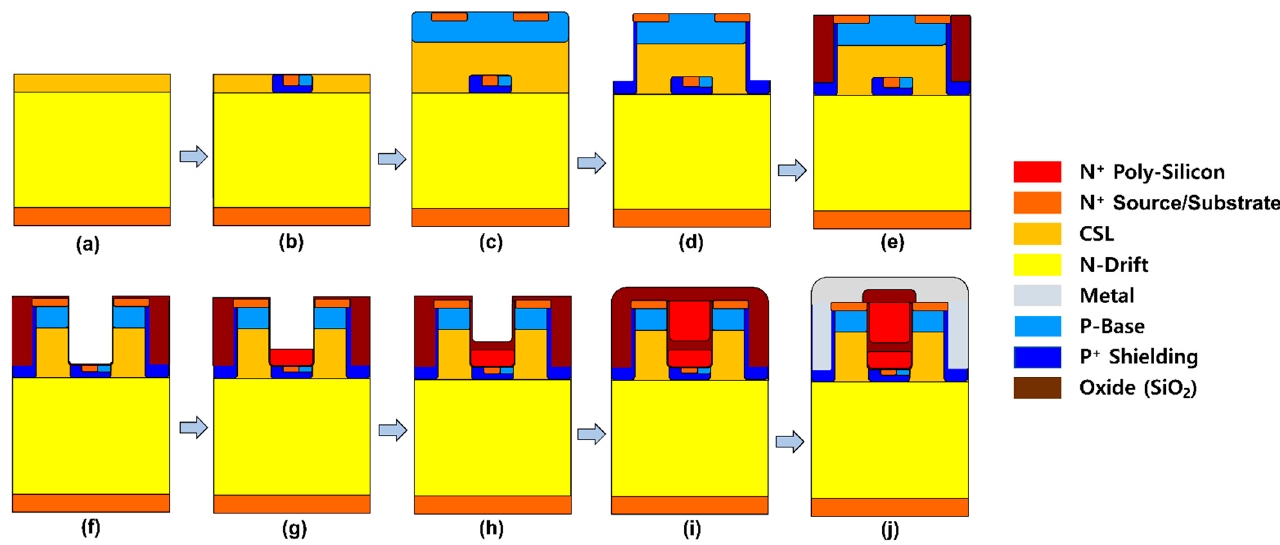
Figure 3. Proposed fabrication procedure of DTMCD-MOSFET. ( a ) N-drift region and CSL region formed by epitaxial growth on N+ substrate. ( b ) BPR region formed by ion implantation. ( c ) Left CSL region and P-base region formed by epitaxial growth; implant N+ source region. ( d ) Trench the source region using RIE etching, and implant P+ region using tilt-ion implantation. ( e ) Fill the source trench with oxide through CVD. ( f ) The gate region trenched; perform the wet thermal oxidation. ( g ) The N+ Polysilicon deposited and etched, forming a dummy gate. ( h ) Wet thermal oxidation conducted again. ( i ) Form an active gate through the deposit of the N+ Polysilicon and the etch-back process. After that, ILD oxide is deposited through the CVD. ( j ) Etch the oxide and complete metal- lization. 3. Simulation Results and Discussions In this section, we present and analyze the simulation results for the electrical char- acteristics of the proposed and compared devices. The simulation was performed using the Sentaurus TCAD tool from Synopsys, and Poisson’s equations and the electron/hole continuity equations were solved in a two-dimensional (2D) MOSFET structure [37]. For the simulation conditions, physical models, such as the mobility, recombination, genera- tion, and avalanche models, and the density of the interface states at the SiC/SiO 2 interface, were performed under the same conditions as in our previous study [18]. Through simu- lations, the static performance of the MOSFETs in their on and off states, the body diode properties of the MOSFETs, and their dynamic performance, including their parasitic ca- pacitance and switching characteristics, were compared. Furthermore, the reverse recov- ery, capacitance, and switching characteristics were simulated using the circuit configuration of the mixed-mode simulation. 3.1. Static Performances Figure 4 depicts the drain current characteristics versus the drain voltage of the DT- MOSFET and DTMCD-MOSFET properties in the on state. Because of the reduced accu- mulation layer caused by the split-gate construction, the R on-sp of the DTMCD-MOSFET was slightly higher than that of the DT-MOSFET, although there were no discernible dif- ferences between the two devices. Figure 5a,b show the current density distribution of the two different-structured DT-MOSFETs with integrated channel diodes in the on state. The proposed DTMCD-MOSFET with the gates separated horizontally is shown in Figure 5a, and a DTMCD-MOSFET with the gates divided vertically is shown in Figure 5b. A chan- nel was not formed in the right P-base region of Figure 5b because the divided right dummy gate was connected to the source. Consequently, no current flowed at the right